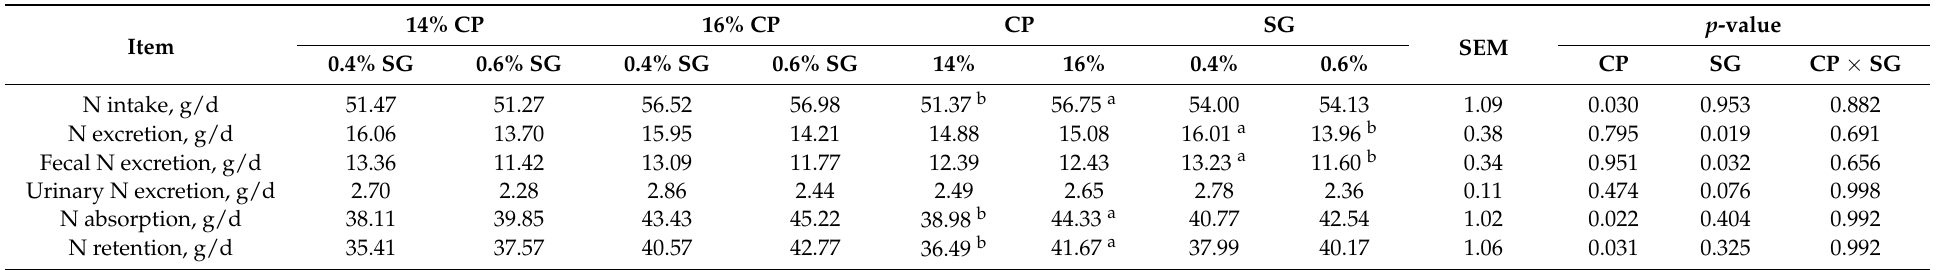
Table 6. Effects of crude protein (CP) levels (14% vs. 16%) in concentrate with S. graniflora pod meal (SG, 0.4% vs. 0.6% dry matter intake) on nitrogen (N) balance in Thai native beef